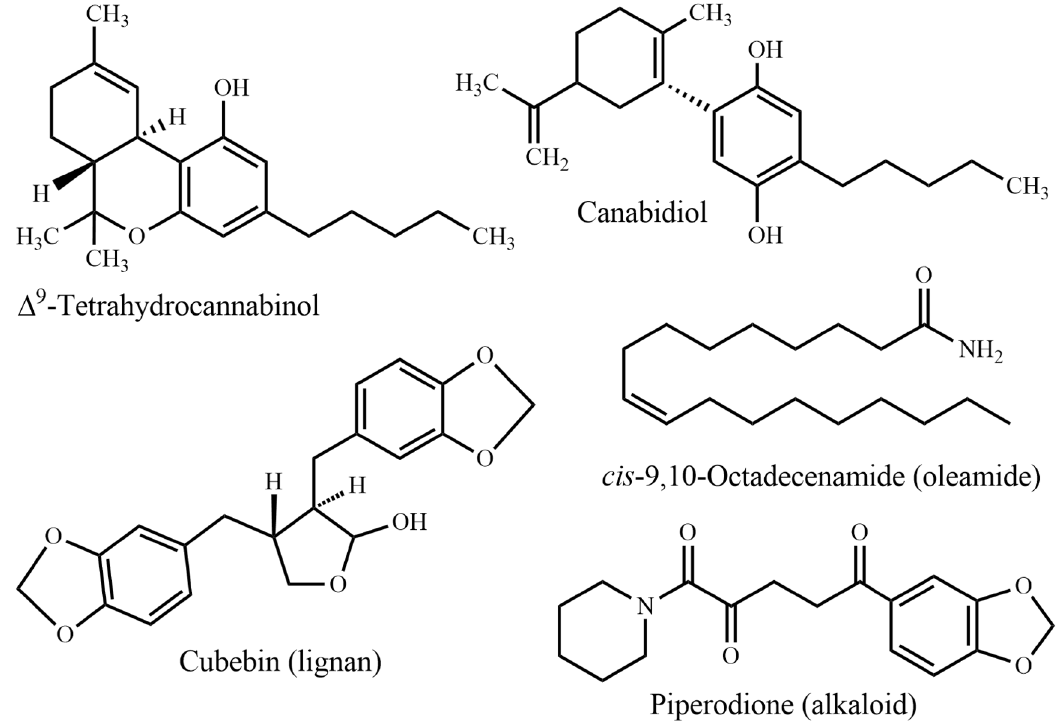
Fig. 14 Miscellaneous (cannabinoid, lignan, oleamide, and